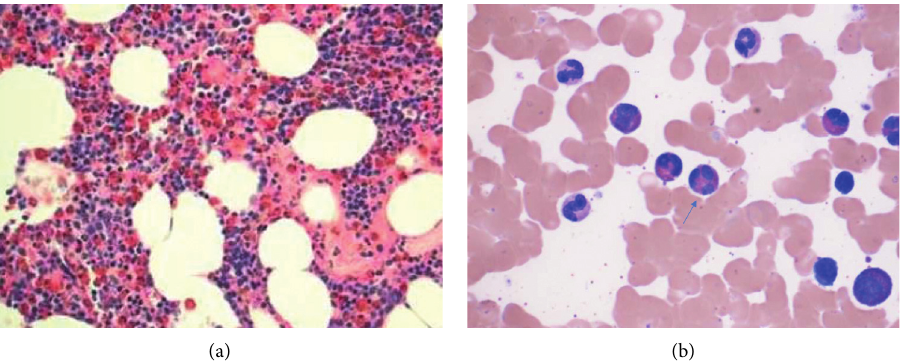
Figure 2: Bone marrow biopsy in a 33-year-old female with a past medical history of multiple sclerosis. (a) H&E (400X magnification) section of the bone marrow biopsy, with trilineage hematopoiesis and a significant interstitial increase in eosinophils. (b) Aspirate at high power (1000X magnification) showing mature eosinophils with rare trilobed nuclei (arrow) and no increase in blasts.